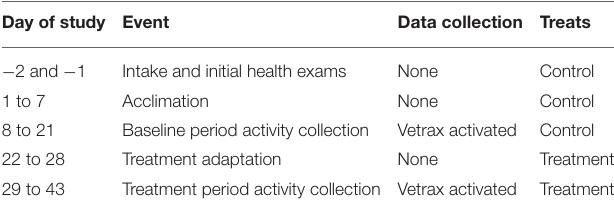
TABLE 1 | Schedule of events for monitoring activity in dogs receiving cannabidiol-containing